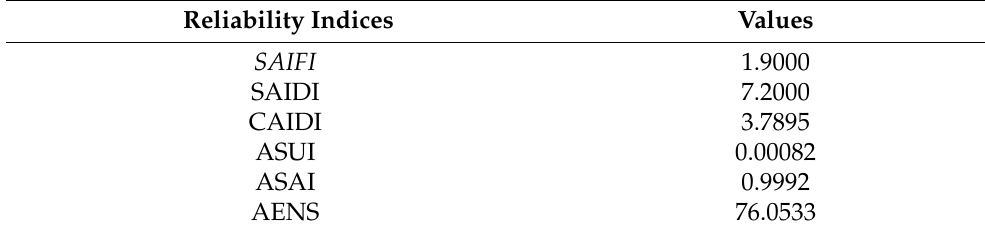
Table 1. Reliability indices of 13-bus system before placement of any recloser.